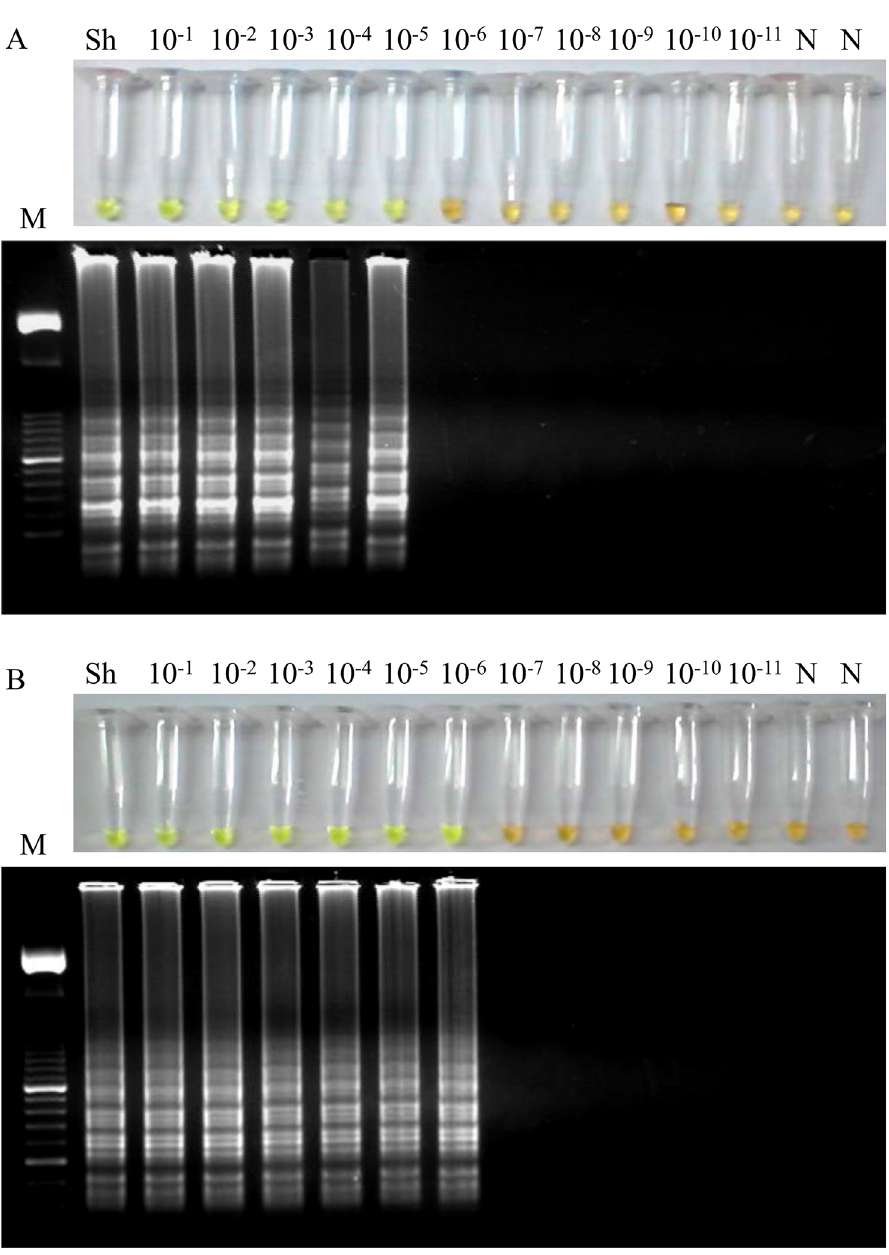
Fig 4. Sensitivity of the LAMP assay in simulated human urine samples artificially contaminated with DNA from S . haematobium . (A) Sensitivity assessment of LAMP when performing the DNA extraction with the i-genomic Urine DNA Extraction Mini Kit (Intron Biotechnology, UK) from serial dilutions of S . haematobium genomic DNA. (B) Sensitivity assessment of LAMP when performing the DNA extraction with a simple heating method from serial dilutions of S . haematobium genomic DNA. Lanes M: 50 bp DNA ladder (Molecular weight marker XIII, Roche); lanes Sh: genomic DNA from S . haematobium (1 ng); lanes 10 − 1 – 10 − 11 : 10-fold serially dilutions; lanes N: negative controls (no DNA template). the detection limit was established in 1 fg/ μ L using the Rapid-Heat LAMPellet method for DNA extraction (Fig 4B).